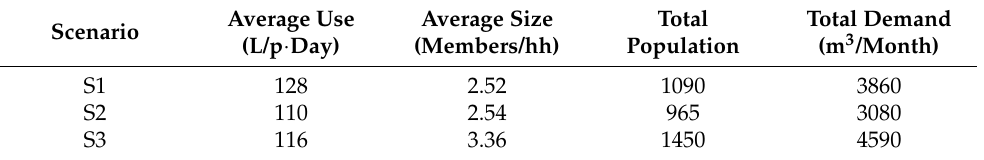
Figure 9. Simulated average water use for the three scenarios. Table 6. Scenario outcomes at the end of the simulation (15